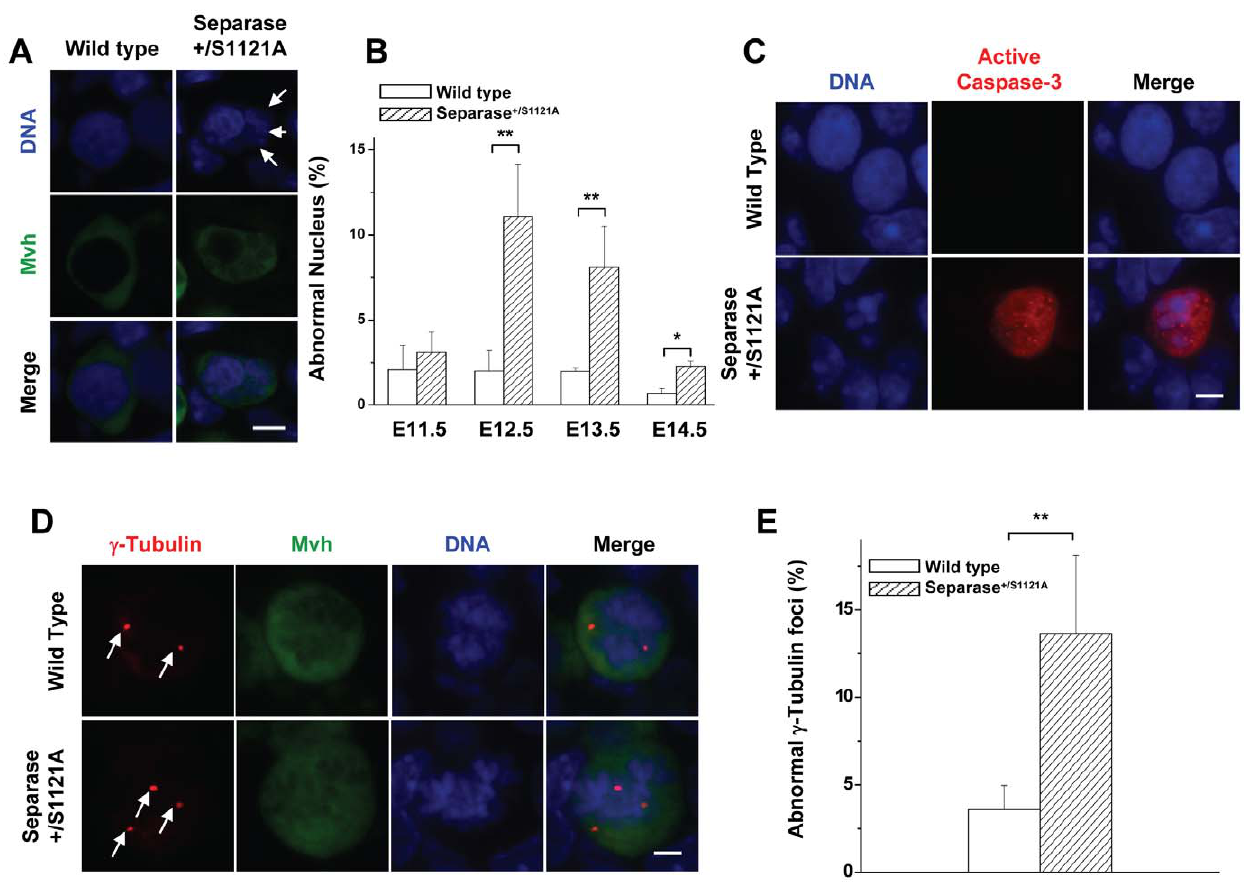
Figure 4. Genome instability in PGCs of female Meox-2-cre/Separase S1121A mutant mice. A. Micronucleus configuration of female PGCs at 13.0 dpc observed by immuno-staining with Mvh (green) and DNA (blue). Arrows indicate the micronuclei. Bar=0.5 m m. B. Quantitative analysis of micronuclei of female PGCs from wild-type and Separase S1121A gonads of various ages as indicated. Serial sections of female genital ridges were stained for DNA and Mvh. All the Mvh-positive cells and the Mvh-positive cells with micronuclei were scored from at least three sections in at least three embryos (six genital ridges) for each time point. The mean value is shown with standard error (** p , 0.001, T test). C. Representative of apoptotic PGCs detected by active Caspase-3 (red)-positive PGC with abnormal nucleus (blue) configuration. Bar=2.0 m m. D. Centrosome number in female PGCs visualized by immuno-staining with c -Tubulin (red), Mvh (green) and DNA (blue). Red dots (arrows) of c -Tubulin staining indicate centrosomes. Bar=0.5 m m. E. Quantitative analysis of abnormal centrosomes of female PGCs at 13.0 dpc. Serial sections of female genital ridges were stained for DNA, Mvh, and c -Tubulin. The Mvh-positive cells with three or more c -Tubulin foci were scored from at least three sections in at least three embryos (six genital ridges). The mean value is shown with standard error (** p , 0.001, T test).